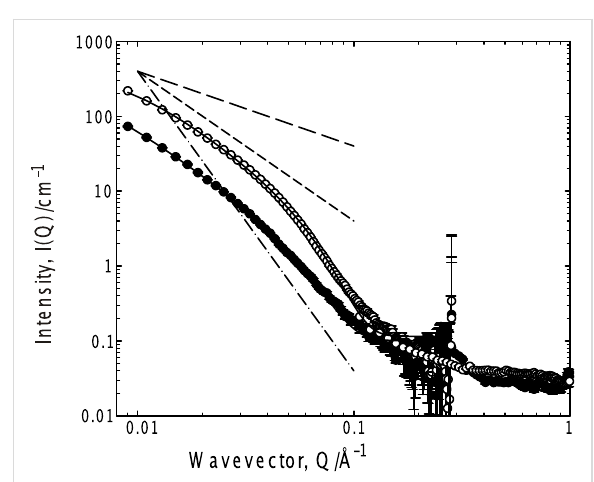
Figure 3. The toluene system was chosen as there is